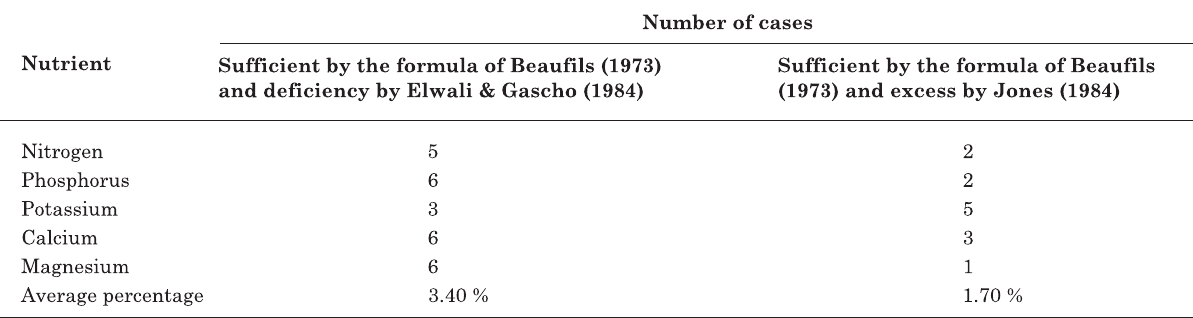
Table 4. Number of cases in which the nutritional status is diagnosed as nutritional equilibrium by the Beaufils method (1973) whereas the Elwali & Gascho (1984) method indicates more limitations by deficiencies and the Jones method (1981) limitations by excess in 153 cupuaçu orchards in the southeastern Amazon